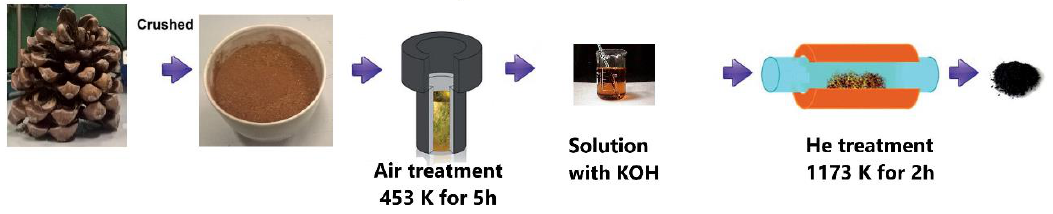
Figure 1. Schematic procedure for the preparation of the activated porous carbons from pinecones.